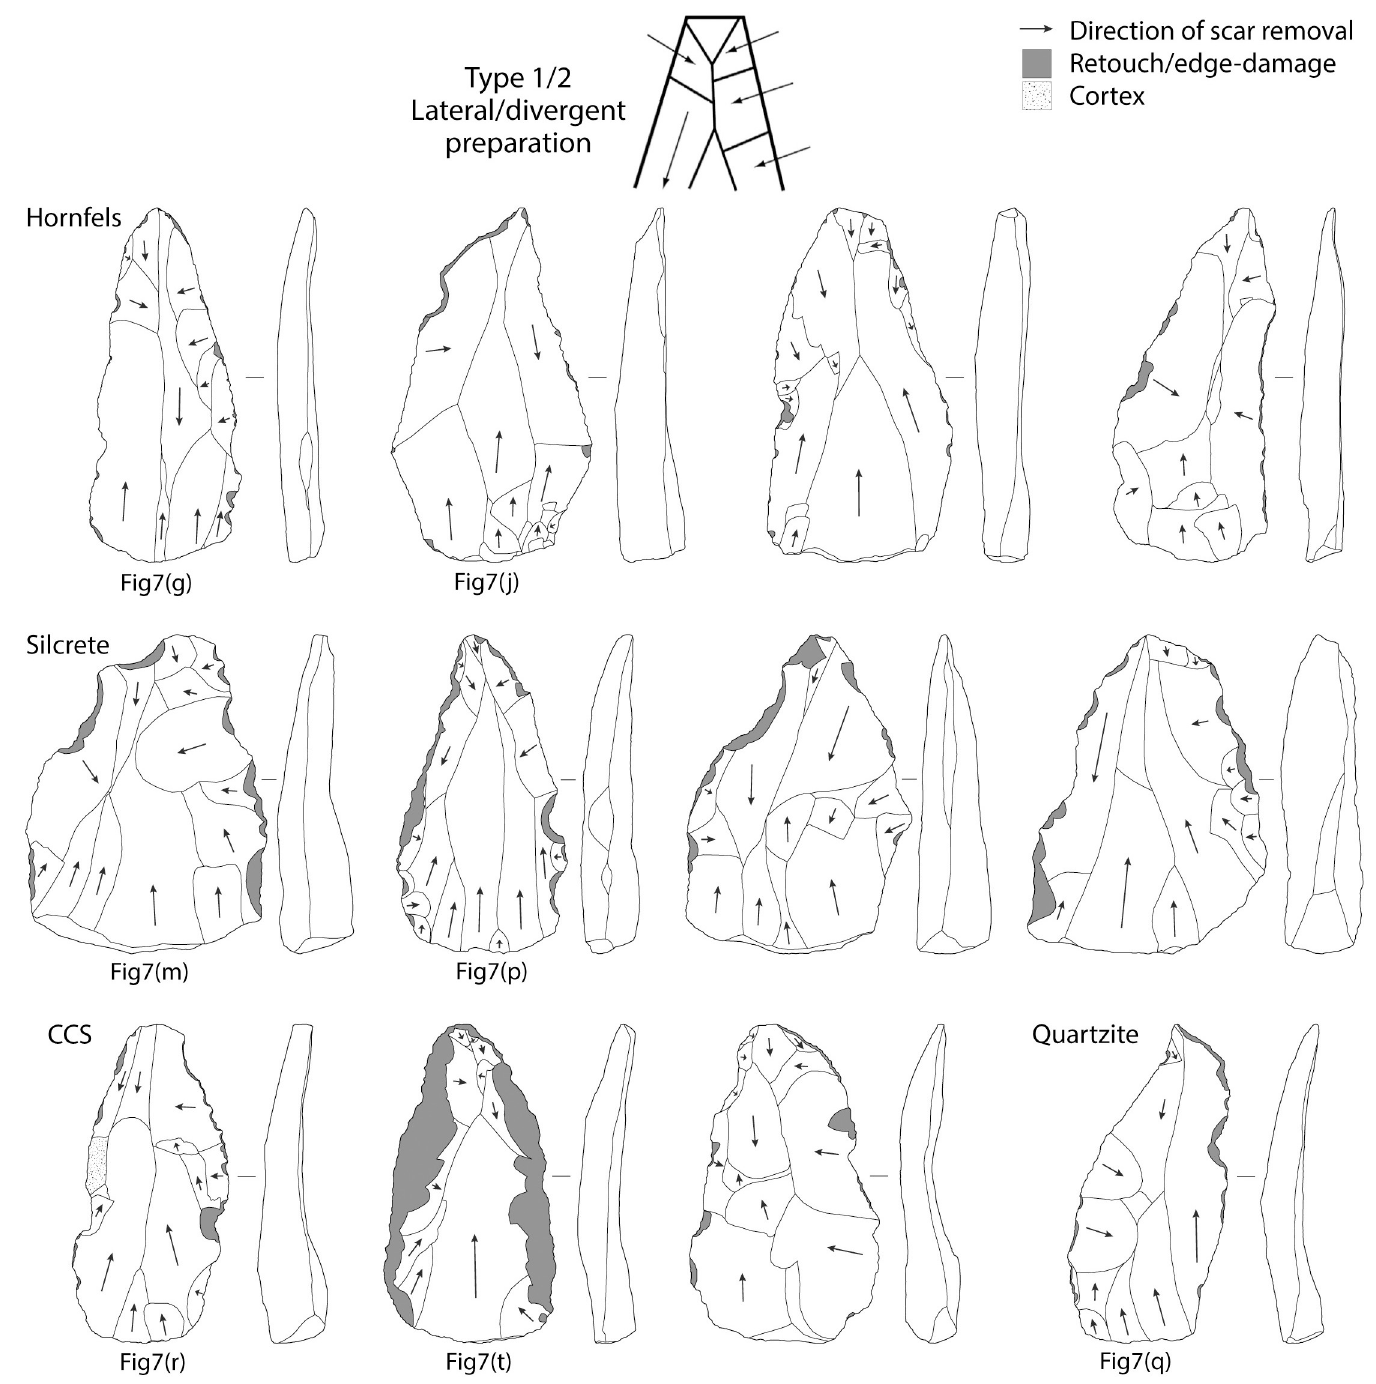
Fig 9. Diagrams of dorsal scar patterning on Tweefontein points related to Nubian Type 1/2 reduction. Points also illustrated in Fig 7 are indicated. Retouch and edge-damage scars are shaded in grey. Artefacts are not to scale. https://doi.org/10.1371/journal.pone.0241068.g009 the assemblage, accounting for 57% (n = 128) and 65% (n = 145) in two 1-metre sample squares, with over 1.3 kg of silcrete in the latter. Silcrete nodules were observed in the general area, with an additional source recorded on top of the plateau immediately to the north.